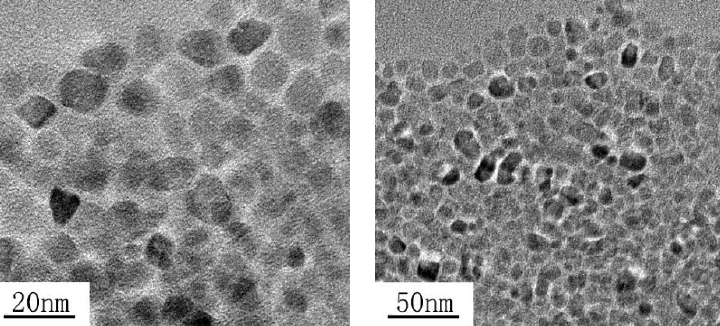
Figure 1. High-resolution transmission electron microscope (HRTEM) image of TiO 2 nanoparticles.